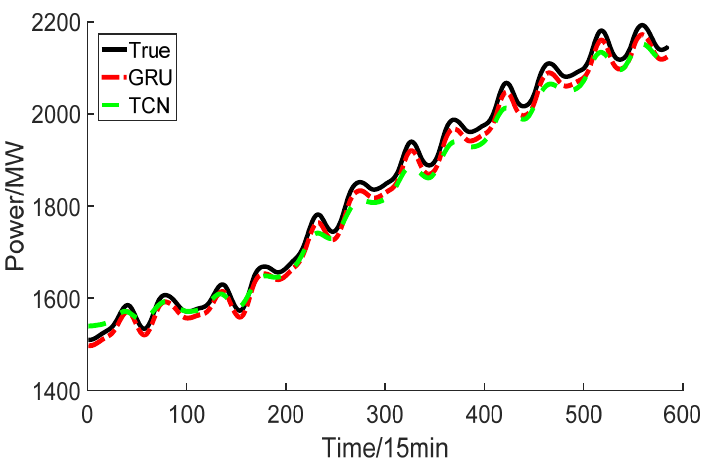
Figure 9. The forecasting results of GRU and TCN with low-frequency component.